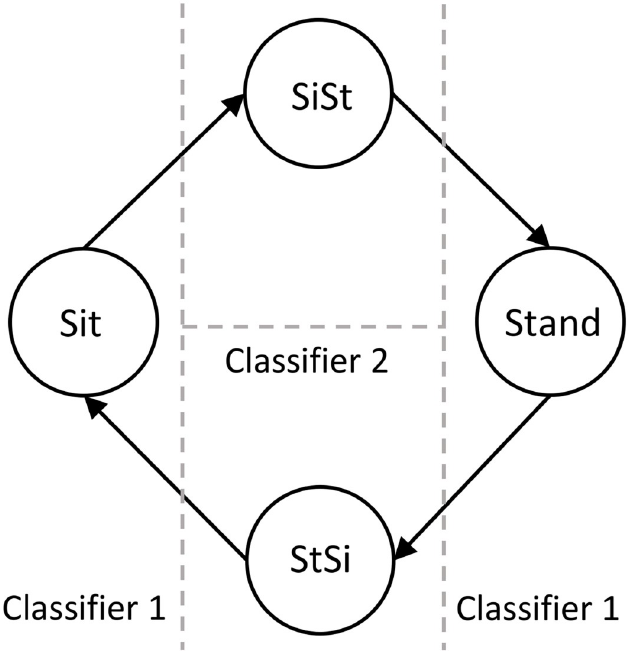
Fig 3. Classification scheme for sit, stand, sit-to-stand and stand-to-sit. State diagram representing the classification scheme for sit, stand, sit-to-stand and stand-to-sit. The vertical dashed line represents the threshold for the Classifier 1 to classify the stationary state and the transition state. The horizontal dashed line represents the classification boundary for Classifier 2 to classify the transition state into sit-to-stand and stand-to-sit.